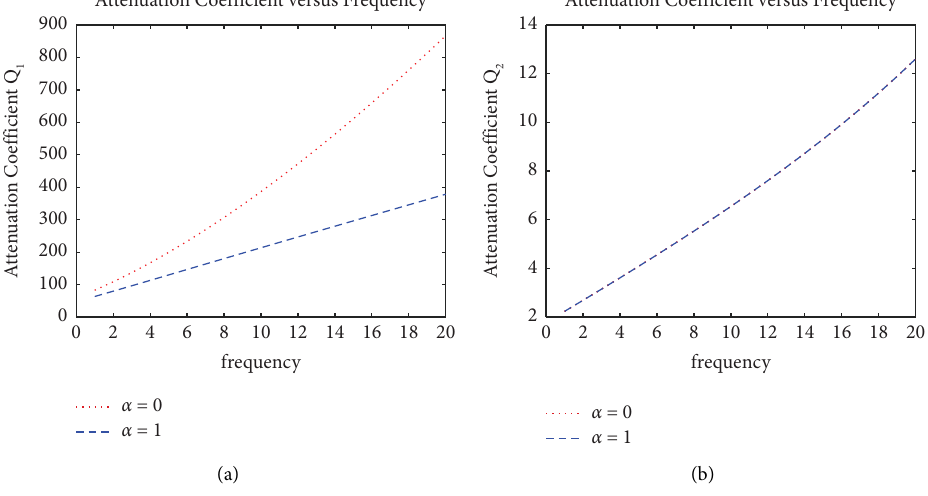
Figure 4: Attenuation coefcient w.r.t. frequency ω